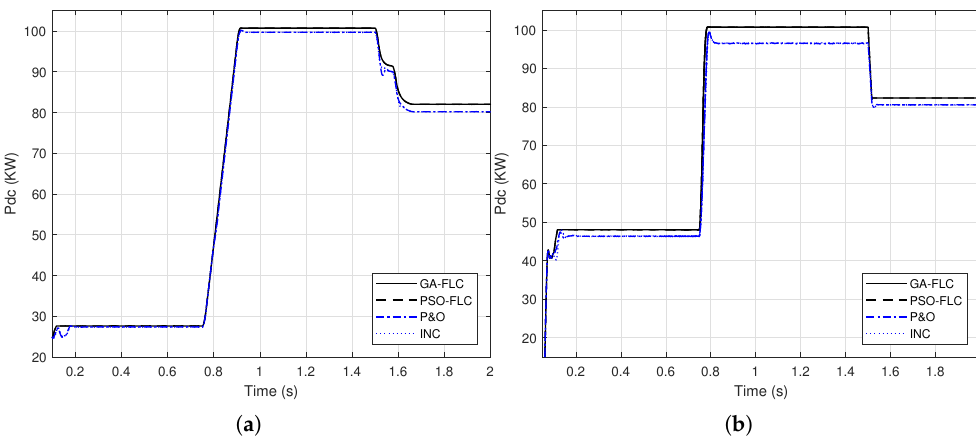
Figure 11. A comparison of the output DC power of the PV array using genetic algorithm (GA)-FLC, particle swarm optimization (PSO)-FLC, perturb-and-observe (P&O) and incremental conductance (INC) for; ( a ) linear variation of G and T c ( b ) step variation of G and T c